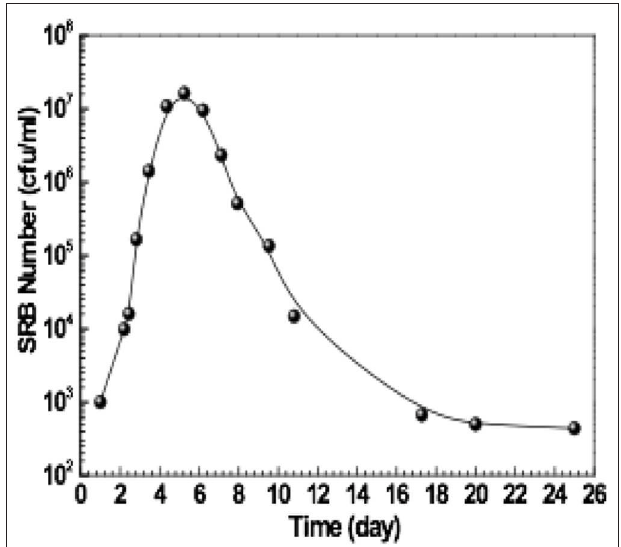
FIGURE 2 | Growth curve of sulfate-reducing bacteria (SRB) in the API RP-38